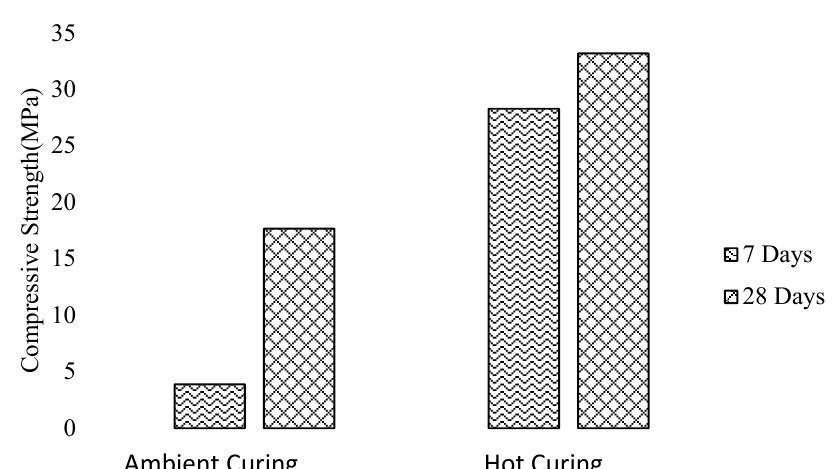
Figure 27. Effect of curing age and curing temperature on compressive strength of FA-based GPC, modified from [165], Academic journals, 2010.